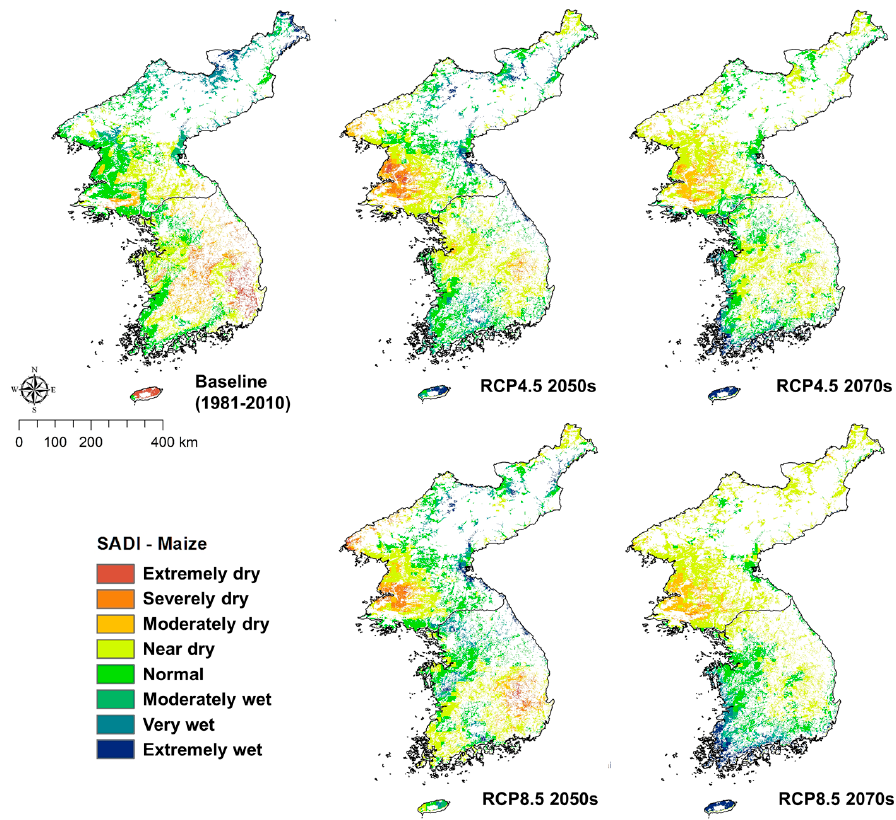
Figure 9. Spatial distribution of the Standardized Agricultural Drought Index for maize (SADI-Maize) in the baseline and future climate scenarios.